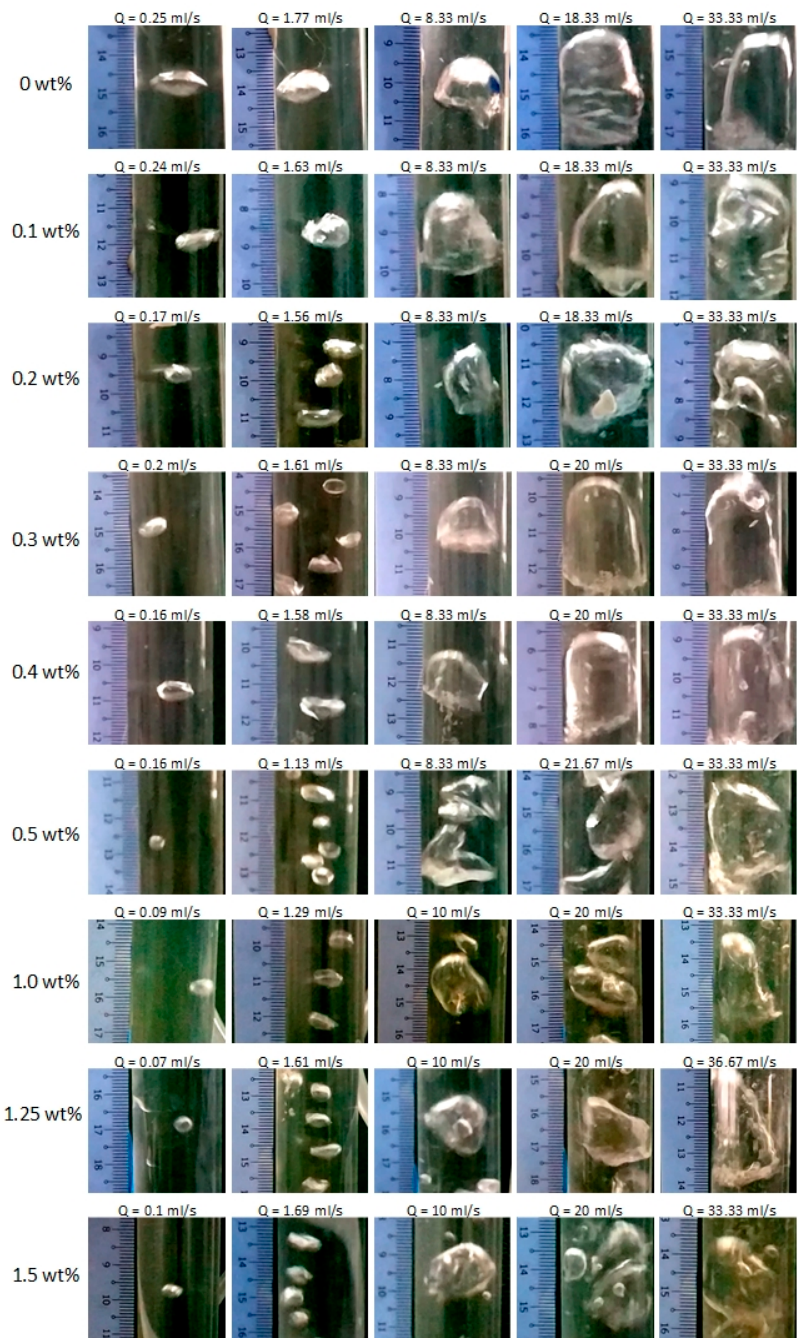
Figure 5. Bubble formations at different coating concentrations under variable air flow rates.